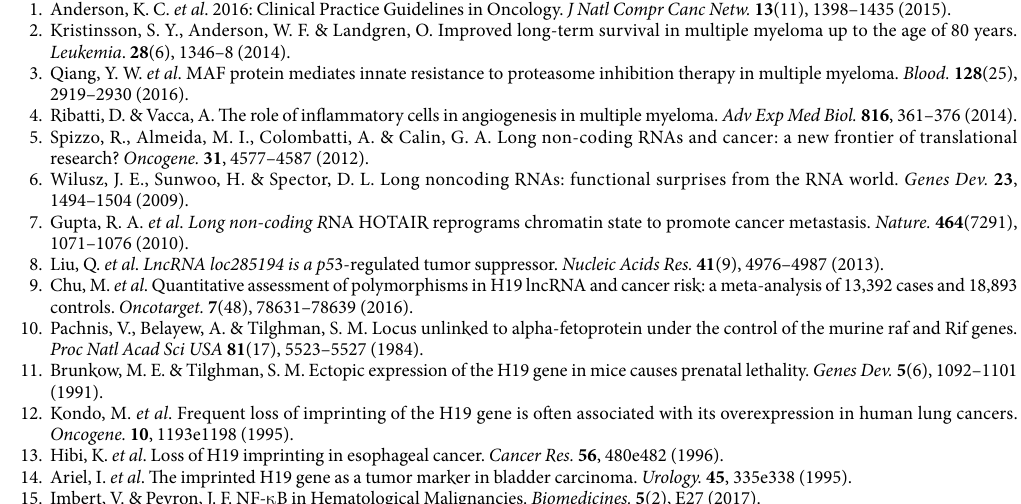
cells. And bone marrow H19 level was positively associated with circulating IL-6 or IL-8 level in the same MM patients. In breast cancer, it was reported that NF- κ B induced cancer progression through targeting IL-6 and IL-8 32,33 . Moreover, at the IL-6 promoter, the canonical NF- κ B complex binds to the region close to the transcrip- tion start site and promotes IL-6 gene expression 34 . Although the precise molecular mechanism of H19-mediated regulation of expression of IL-6 and IL-8 in MM is still unknown, given the previous study, we speculated that H19 might function as a transcriptional promoter by binding to the promoter regions of these genes. And further studies are needed. The NF- κ B pathway is believed to be a potential therapeutic target for cancer 35 . For example, bortezomib, proteasome inhibitor which inhibits NF- κ B activation, has been widely used to treat MM patients worldwide 36,37 . However, given NF- κ B’s pleiotropic and ubiquitous functions, therapeutically targeting this pathway might be an insurmountable challenge. And lots of current NF- κ B-targeting strategies indeed lack cancer cell specificity 38 . Our current study and previous publications have suggested that expression of H19 was cancer cell specific. More importantly, downregulation of H19 could inactivate NF- κ B, and acts in synergy with NF- κ B to inhibit cell growth in MM. As a result, downregulation of H19 expression could have an important implication for the clin- ical management of MM. Further investigation is needed, and whether H19 presents with any toxicity to normal cells should be clear up front. In conclusion, we revealed the oncogenic effects of H19 in MM, and elucidated the potential mechanism by which H19 is implicated. Knockdown of H19 can suppress proliferation, growth and colony formation in MM cells by directly repressing NF- κ B pathway. H19 expression in bone marrow is associated with poor prognosis, and inhibiting it represents a potential strategy against MM.